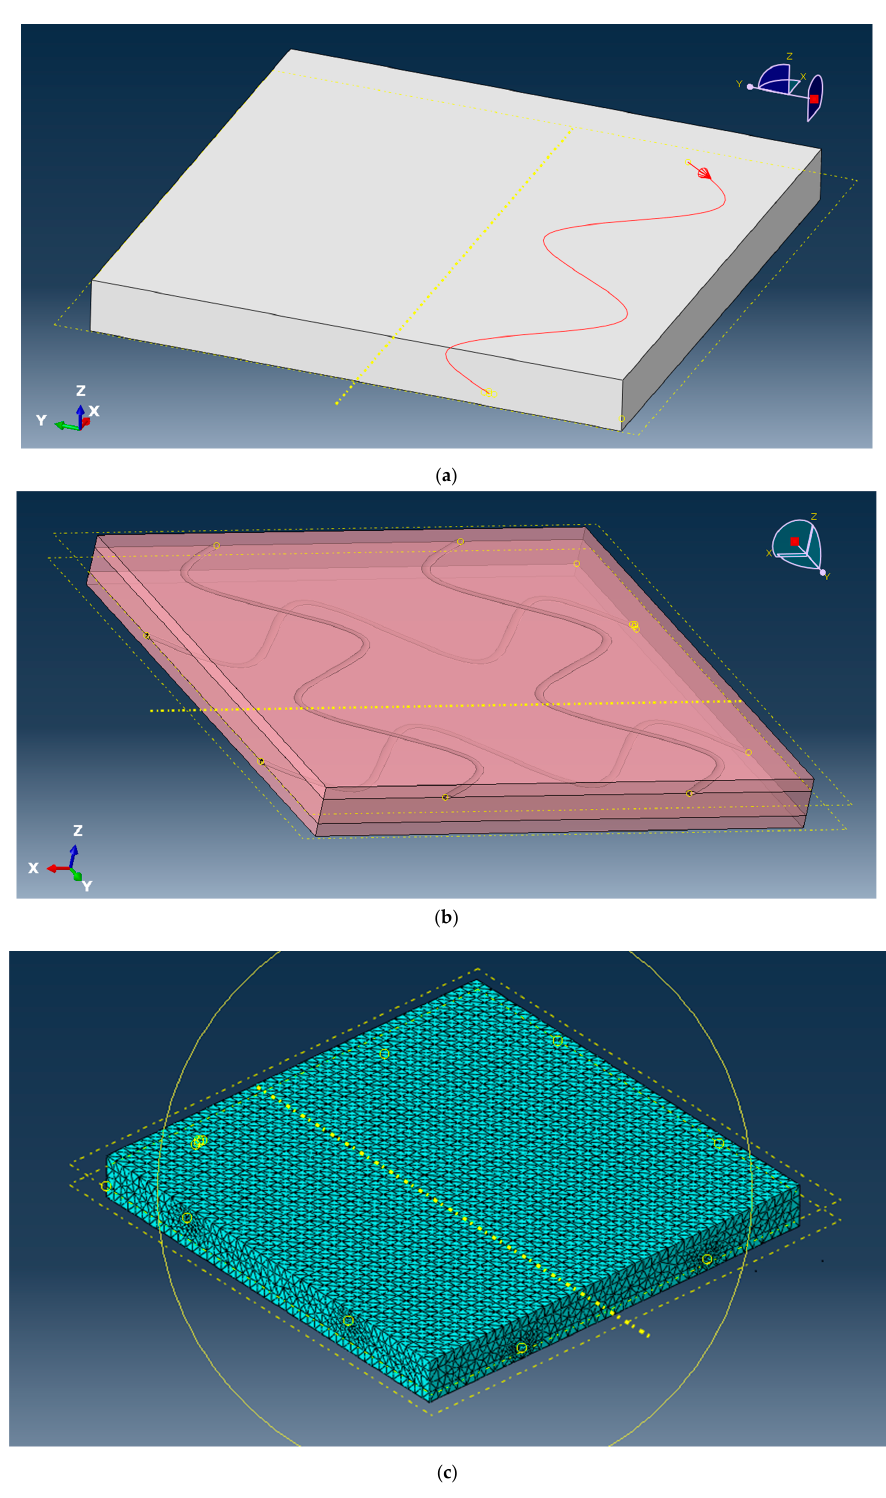
Figure 10. Design of a coconut-inspired plate model with microchannels. ( a ) Defining a path for a microchannel; ( b ) A microchannel network; ( c ) A finite element model. microchannel; ( b ) A microchannel network; ( c ) A finite element